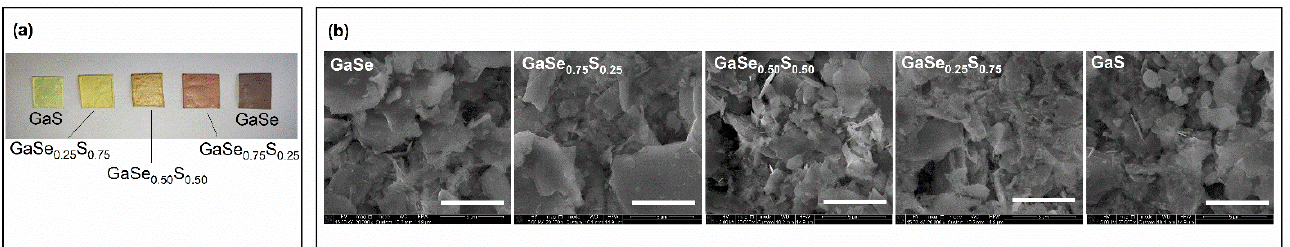
Figure 7. Optical ( a ) and SEM ( b ) images of the prepared LPE GaSe 1 − x S x films (scale bar 5 μm ).